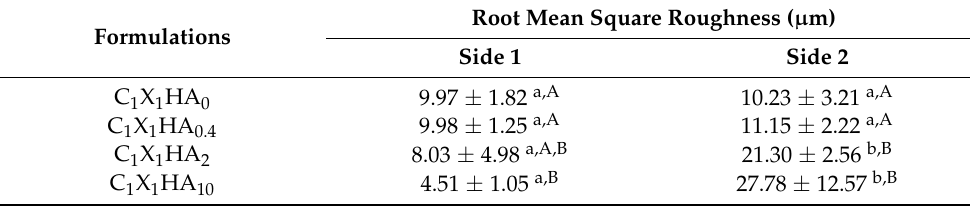
Table 1. Surface roughness (Rq) of C-X membranes added or not with HA determined by confocal microscopy analysis.